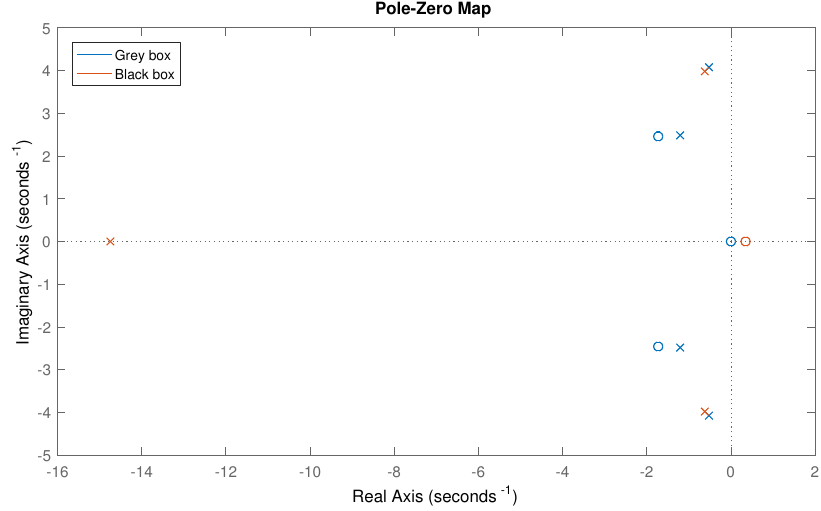
Figure 25. Comparison between the Pole-Zero maps of the Back-box and the Grey-box